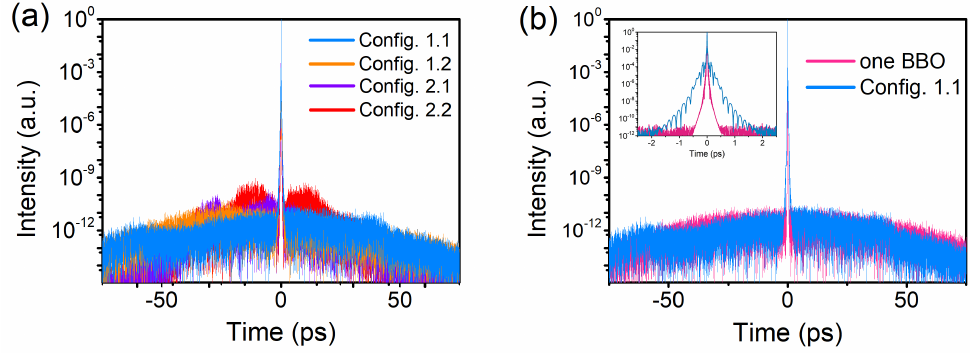
Figure 6. ( a ) Temporal contrast in Config 1.1 (blue), Config 1.2 (orange), Config 2.1 (purple) and Config 2.2 (red). ( b ) Temporal contrast in traditional one BBO arrangement (pink) and Config 1.1 (blue).